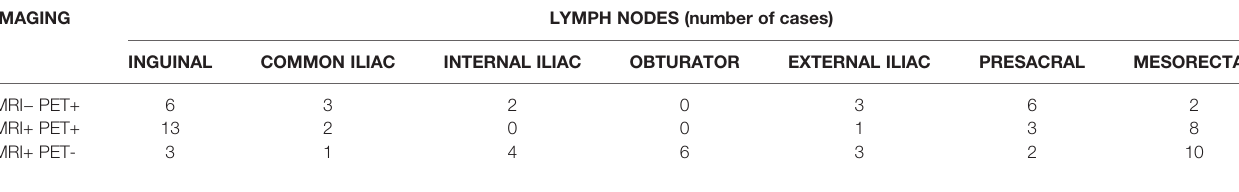
TABLE 2 | Distribution of positive lymph-nodes in our sample of patients detected with 18FDG-PET/CT and/or MRI. IMAGING LYMPH NODES (number of cases)